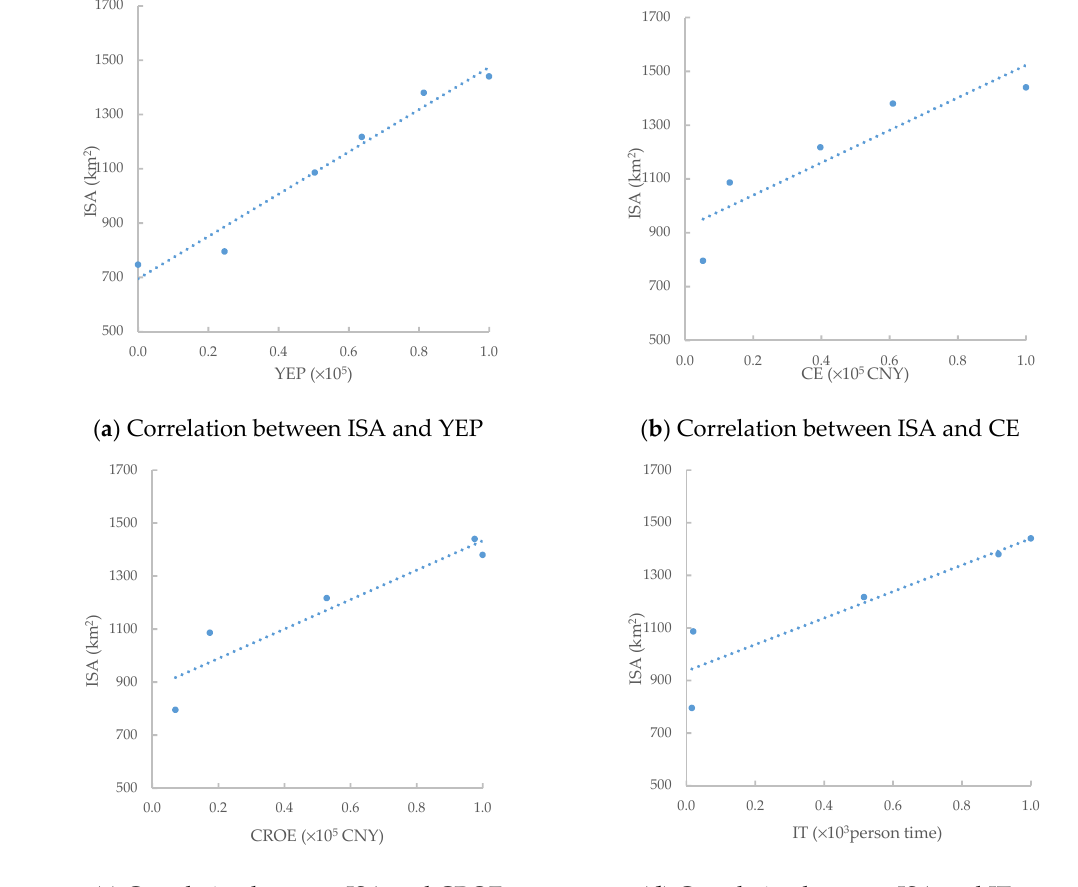
Figure 12. Correlation between ISA and cultural indicators.